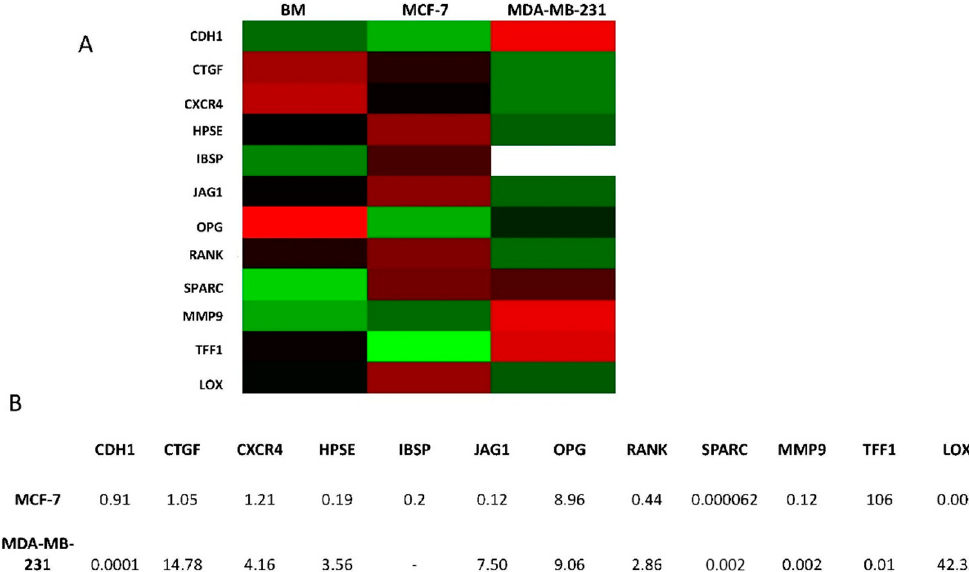
Figure 4. Gene expression analysis of aggressiveness and osteomimicry markers. ( A ) Heatmap configuration of gene expression analysis in BM primary culture and breast cancer cell lines; green/red bars refer to high/low gene expression, respectively; black bars refer to intermediate levels of expression; ( B ) Gene expression quantification by comparative threshold cycle ( C t ) value method ( ∆∆ C t ). The primary culture was chosen as calibrator. See the Experimental Section for selected genes.